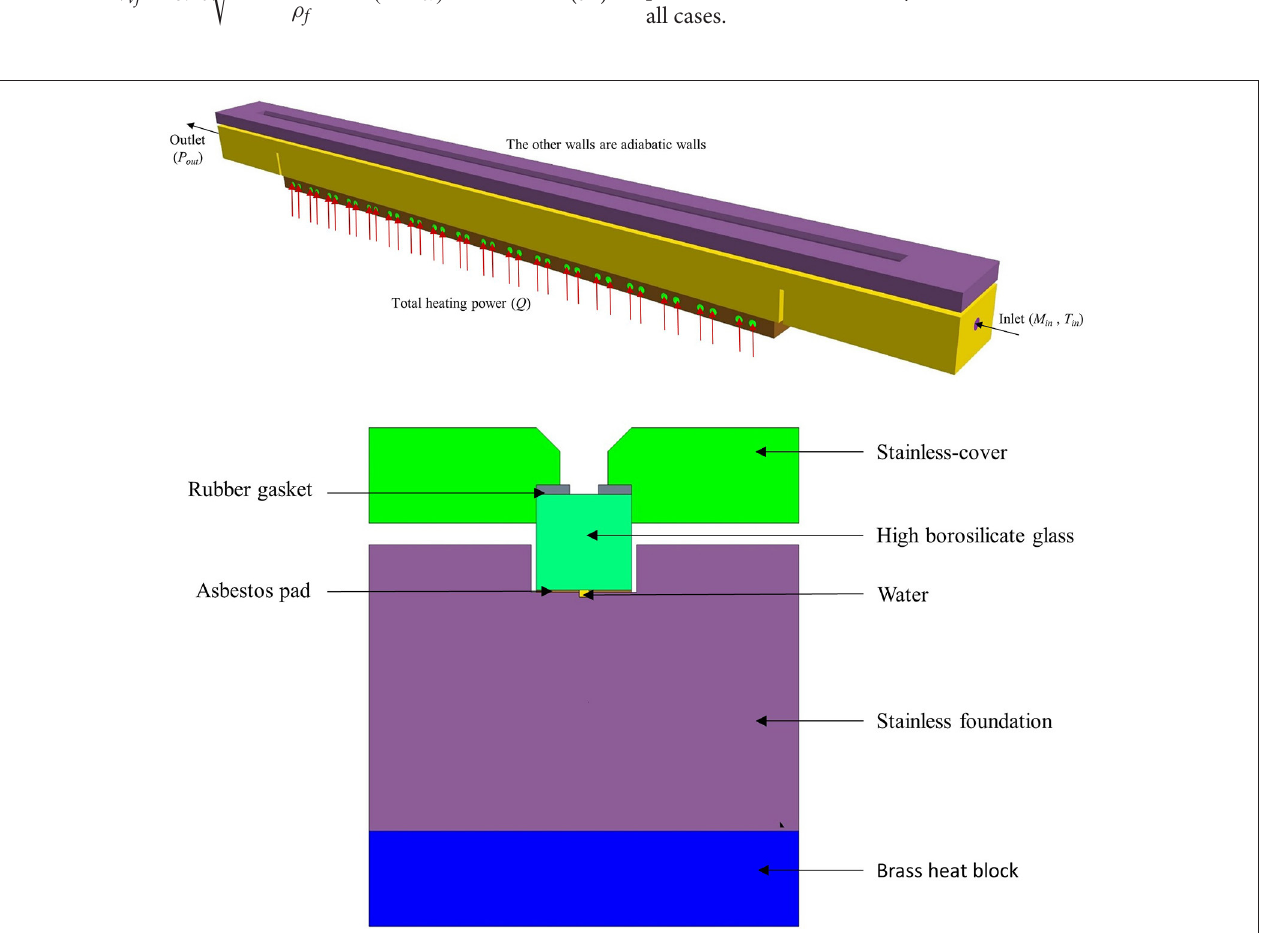
FIGURE 4 | The numerical model and boundary